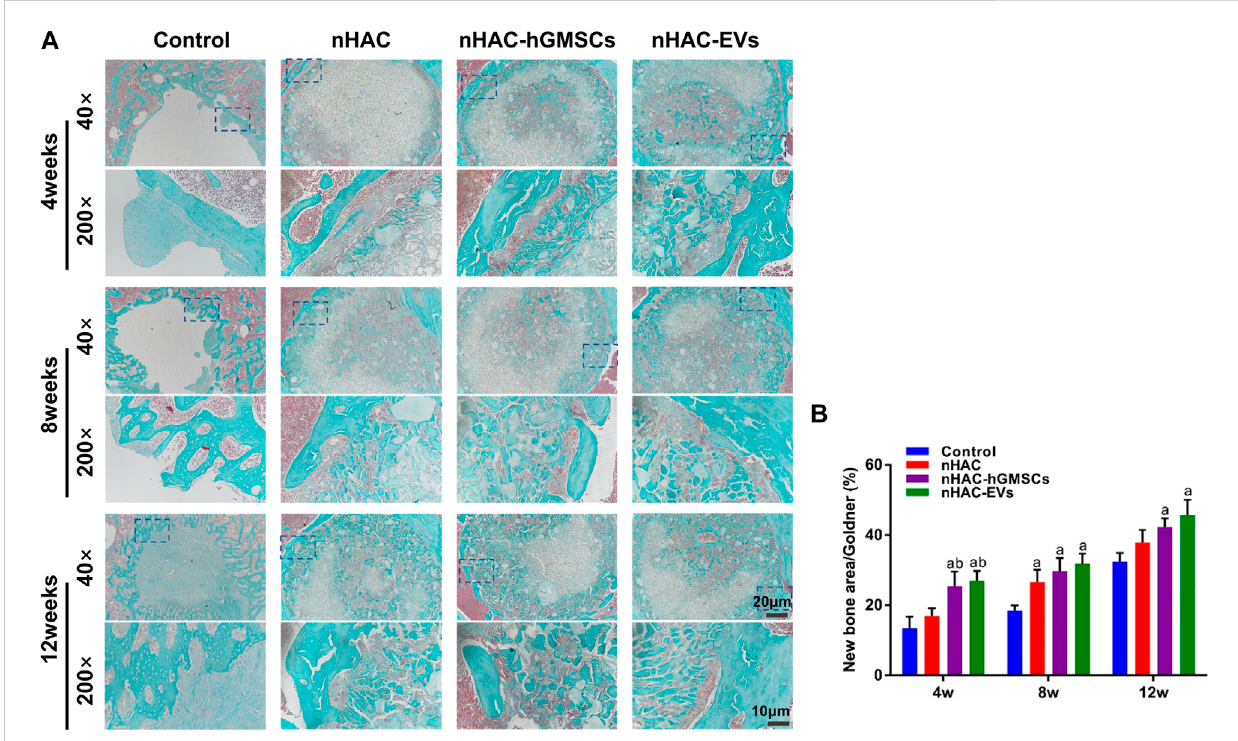
FIGURE 8 Goldner staining results of bone regeneration (A) Representative images of Goldner staining of the bone defect area. The 200× image is an enlargement in the dashed box of the 40× image (B) Quantitative analysis of new bone. a, p < 0.05 compared with the control group; b, p < 0.05 compared with the nHAC